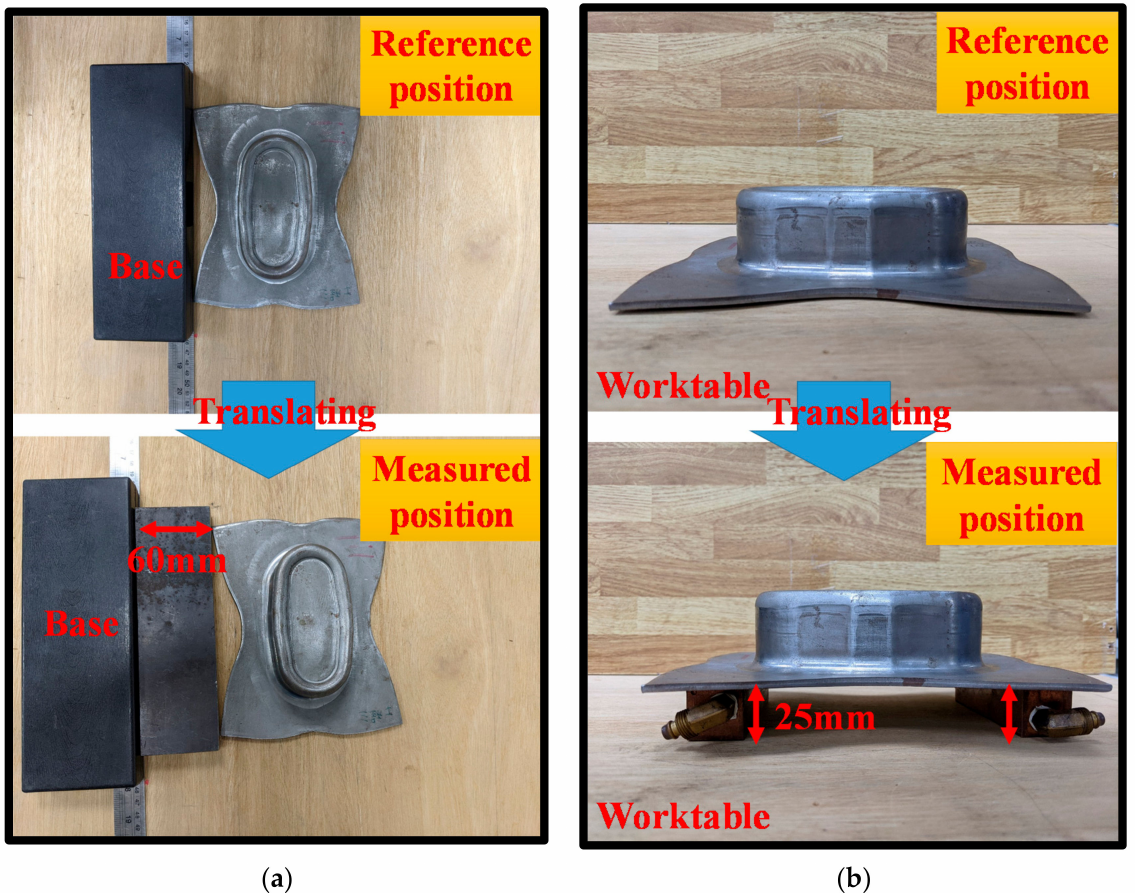
Figure 8. Setup of standard positions for different estimation poses of the dynamic workpiece using a predetermined dimension block for ( a ) the X -axis and Y -axis and ( b ) the Z